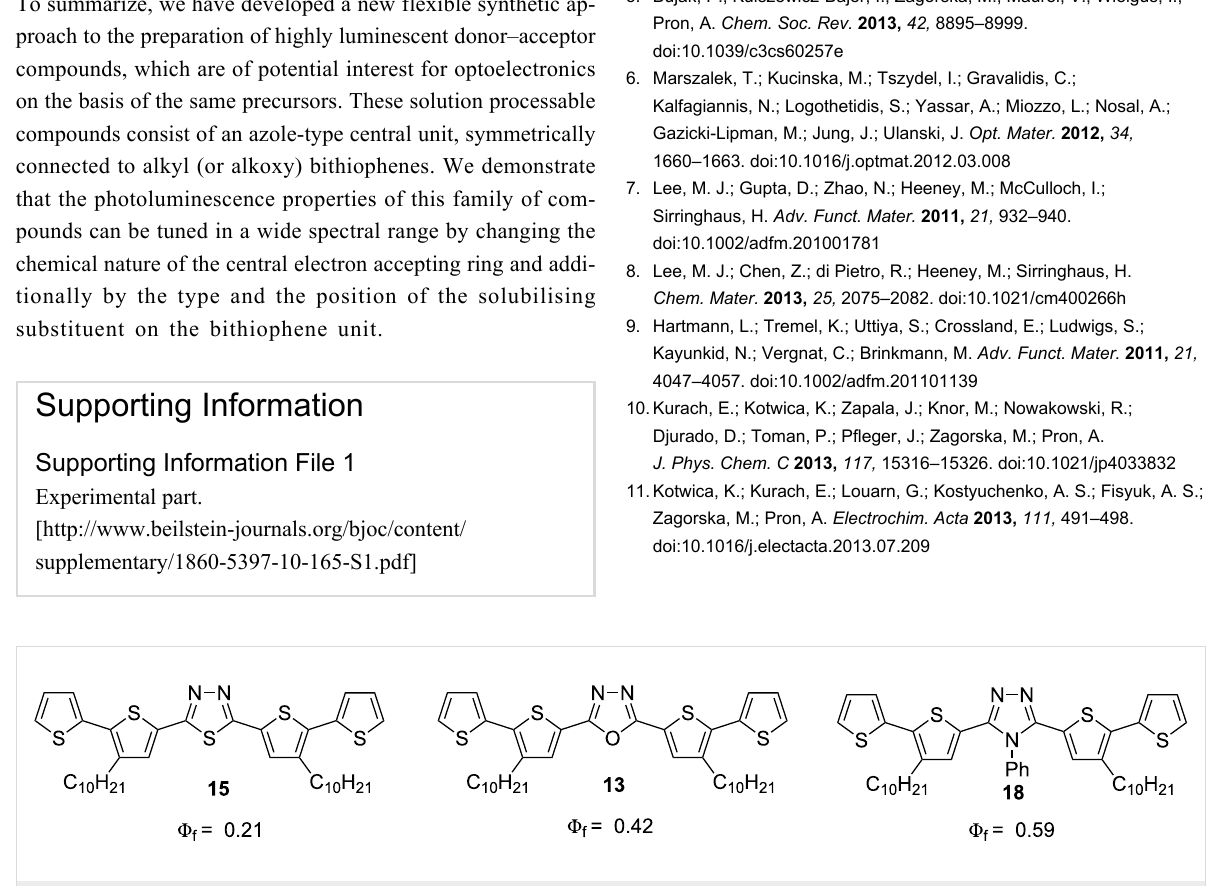
Figure 2: Photoluminescence quantum yields measured for 13 , 15 and 18 together with their